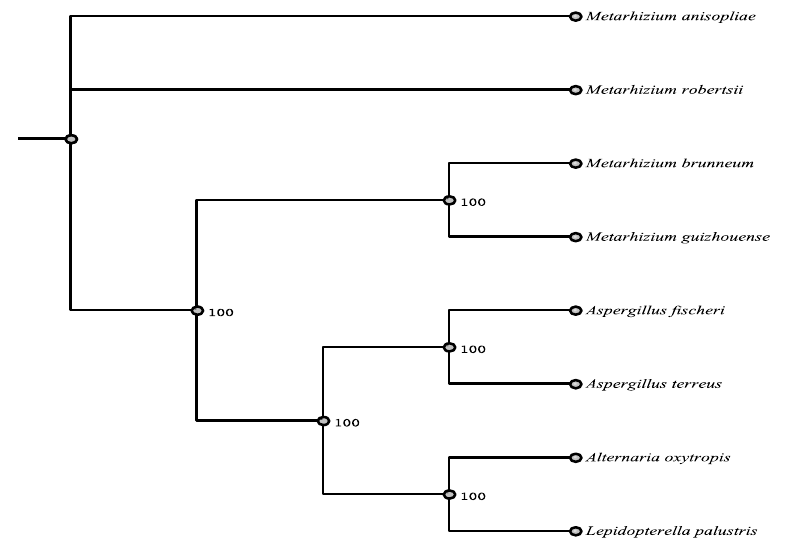
Figure 7. Maximum parsimony tree (MUSCLE alignment and 1000 replicates). Aspergillus fischeri was used as the outgroup. Fungi in tree are pblast results of 3398 sequence.